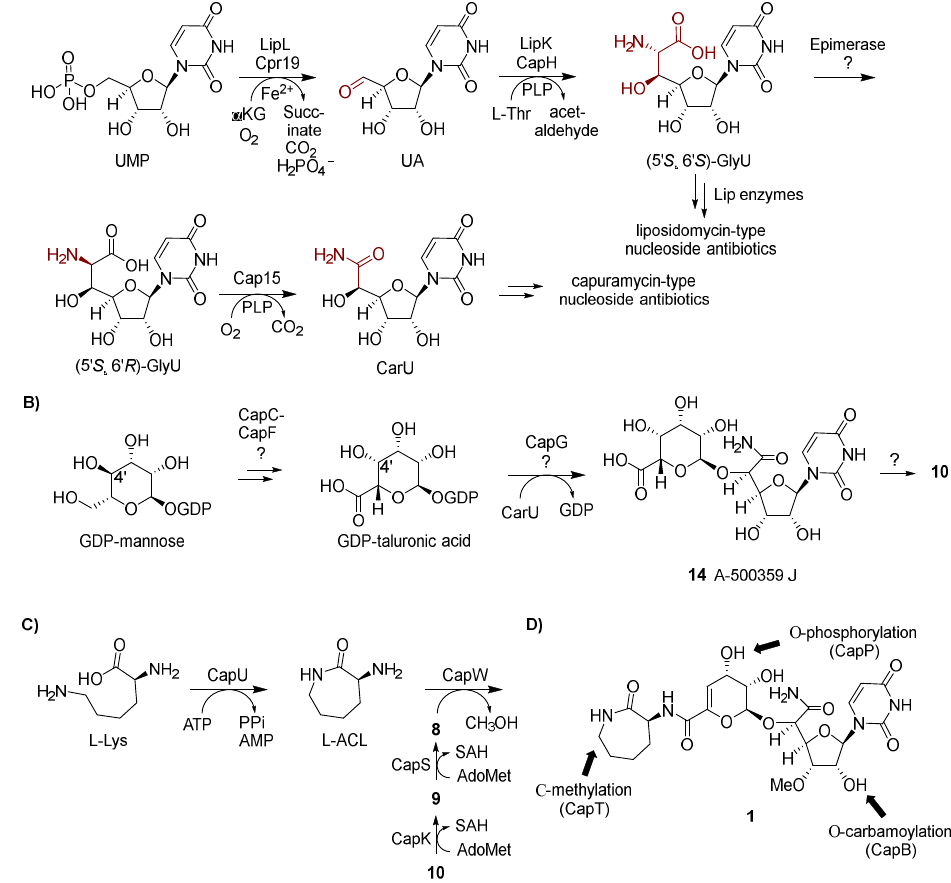
Figure 5. Biosynthetic pathway for the capuramycin-type nucleoside antibiotics. ( A ) Biosynthetic pathway leading to uridine-5’-carboxamide (CarU). αKG, α-ketoglutarate; UA, uridine-5′-aldehyde; PLP, pyridoxal 5’-phosphate; GlyU, 5’- C -glycyluridine. ( B ) Proposed biosynthetic pathway leading to the 4,5-dehydro- D -manno-pyranuronate component. ( C ) Biosynthetic pathway leading to the formation and attachment of the L -aminocaprolactam ( L -ACL). ( D ) Group transfer reactions that occur after the assembly of the signature capuramycin scaffold.